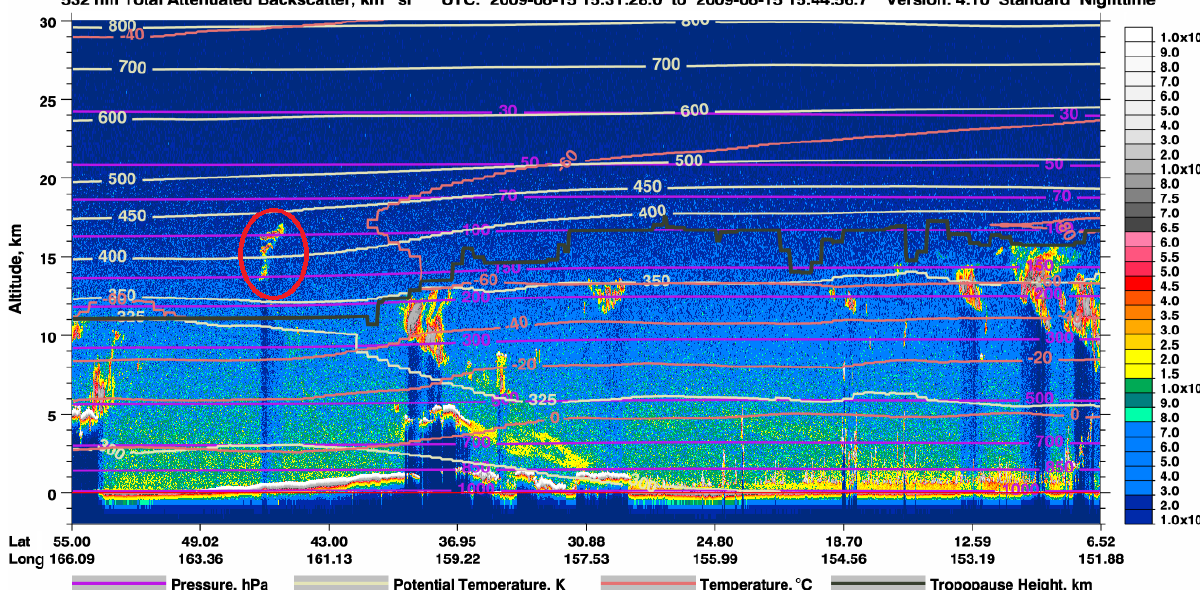
Figure 3. A CALIOP swath containing volcanic aerosol at latitude 46 ◦ N and altitudes between 13 and 17km (red circle). This CALIOP swath is also used in Fig. 5. This figure is part of the CALIOP browse images from NASA.